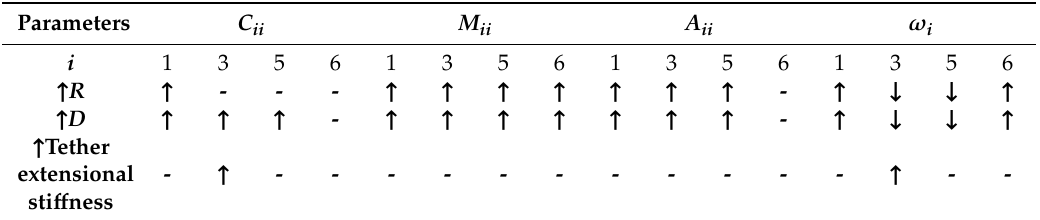
Figure 4. Sketch of support platform for the SWAY model. Table 5. Parameters’ influences on the natural frequencies of SWAY model ( ↑ : increase; ↓ : decrease; -: negligible e ff